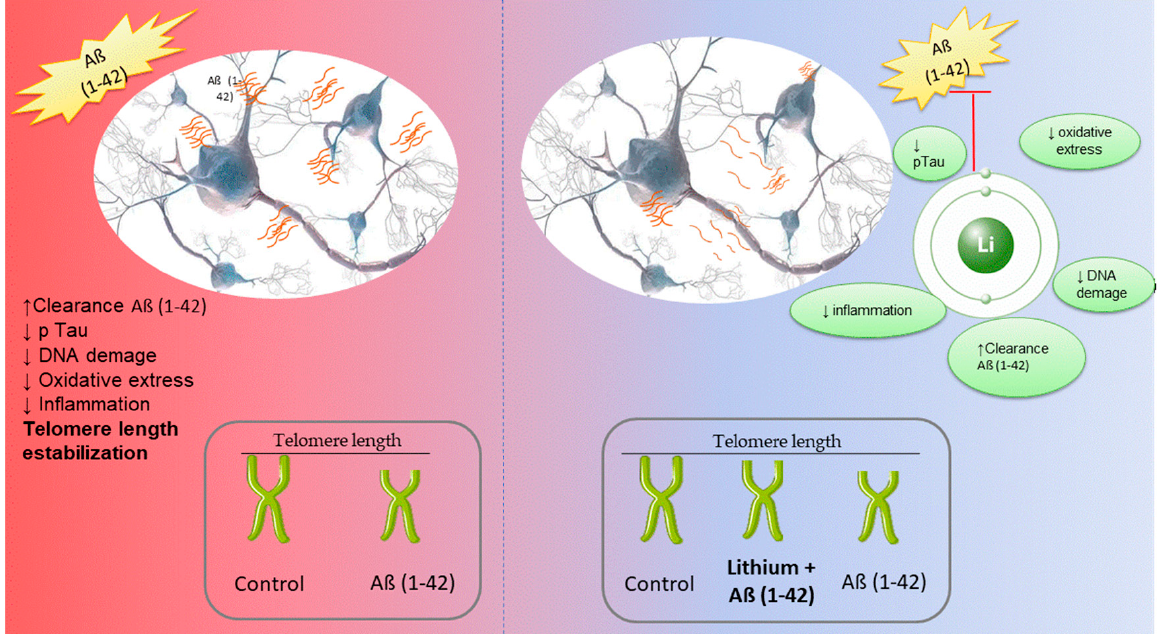
Figure 3. Representative image of the protective effect of lithium on cortical neurons, changes in cell viability and effect with telomere size.